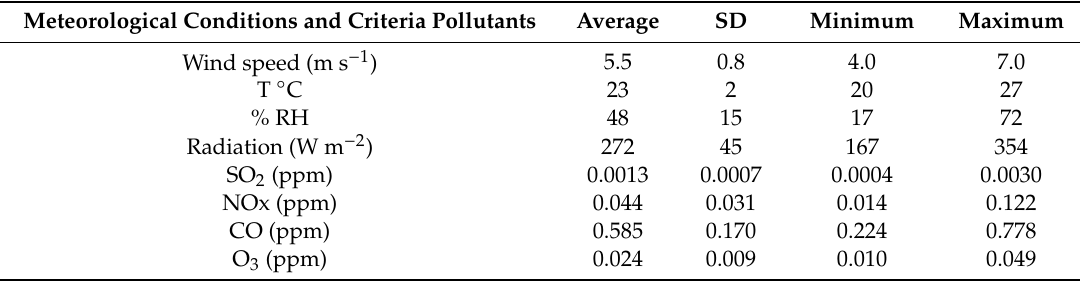
Table 1. Meteorological conditions and criteria pollutants during the sampling period.